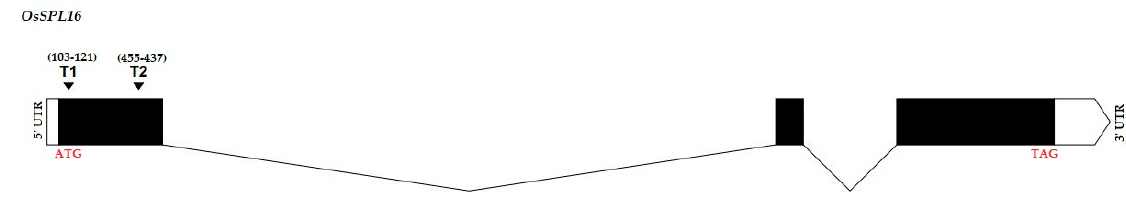
Figure 8. Location of both single guiding RNAs (sgRNAs) in OsSPL16 gene. T1 and T2, represent first and second target sites, respectively. The black boxes represent codon regions.